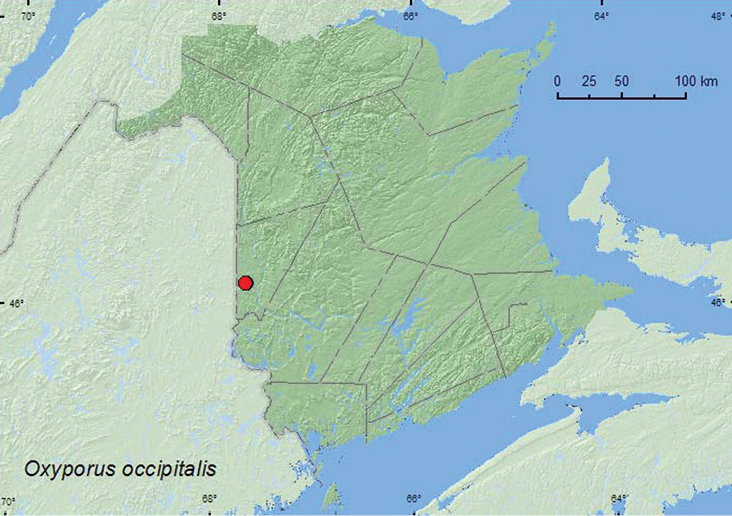
Collection localities in New Brunswick, Canada of Oxyporus occipitalis.